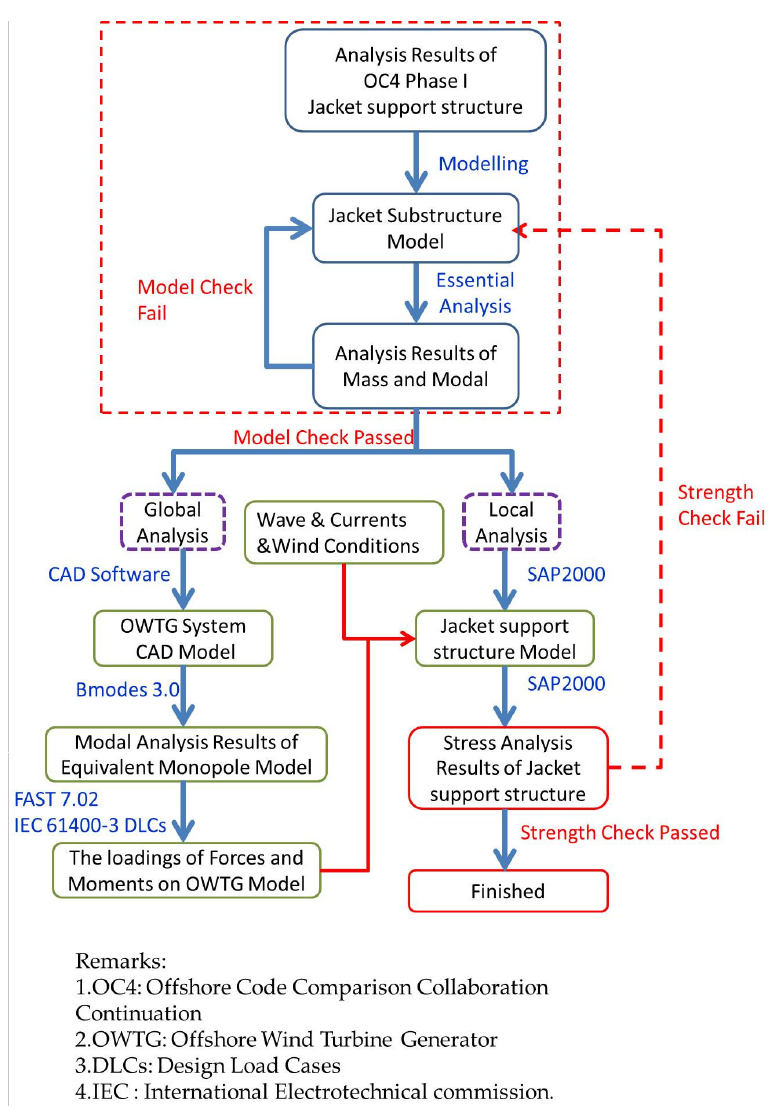
Figure 1. Frame of the proposed Low Cost Analysis Method for Jacket Support Structure.